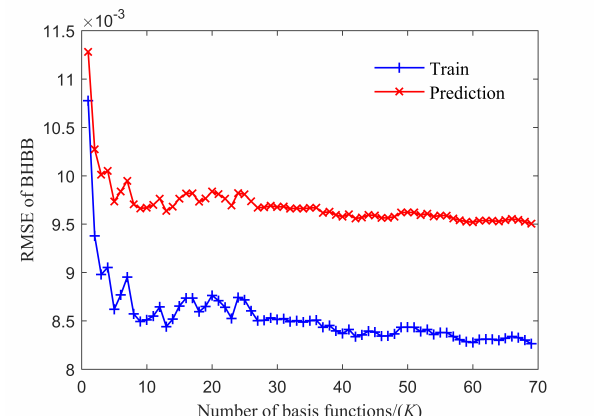
Figure 3. RMSE curve of BHBB for training and prediction in